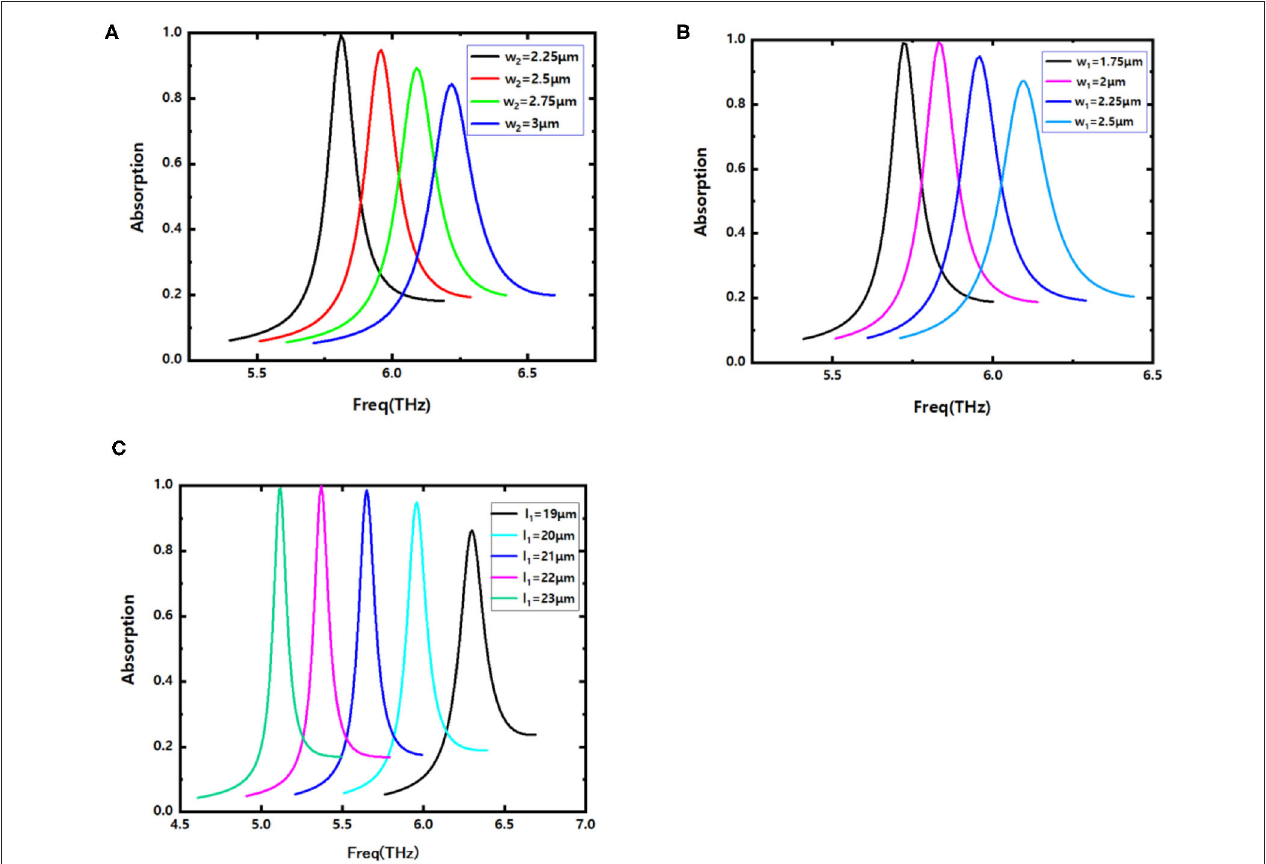
FIGURE 4 | Absorption spectra with (A) different gap widths w 2 ; (B) different metal strip width w 1 ; (C) different metal strip length l 1 .